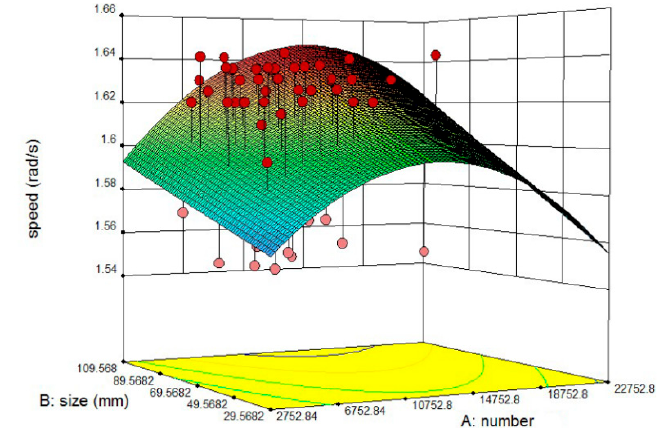
Processes 2020 , 8 , x FOR PEER REVIEW Figure 8. Three-dimensional surface diagram of the response surface. Figure 8. Three-dimensional surface diagram of the response surface.